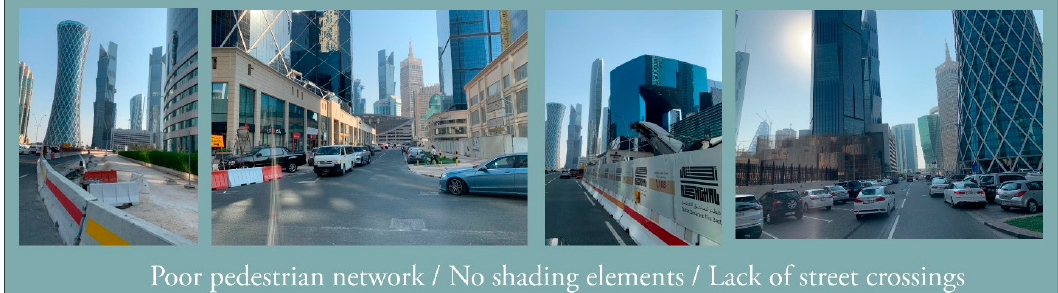
Figure 22. Illustration of poor connectivity, unshaded walkways, and lack of street crossings (Source: the Authors). Designs 2021 , 5 , x FOR PEER REVIEW